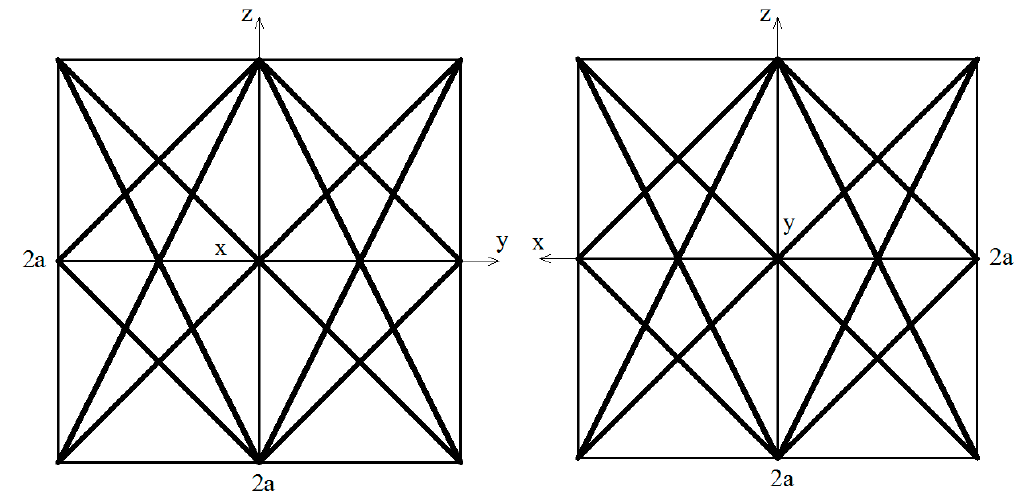
Figure 4. Geometry of an eight-module supercell—axonometry and three views.